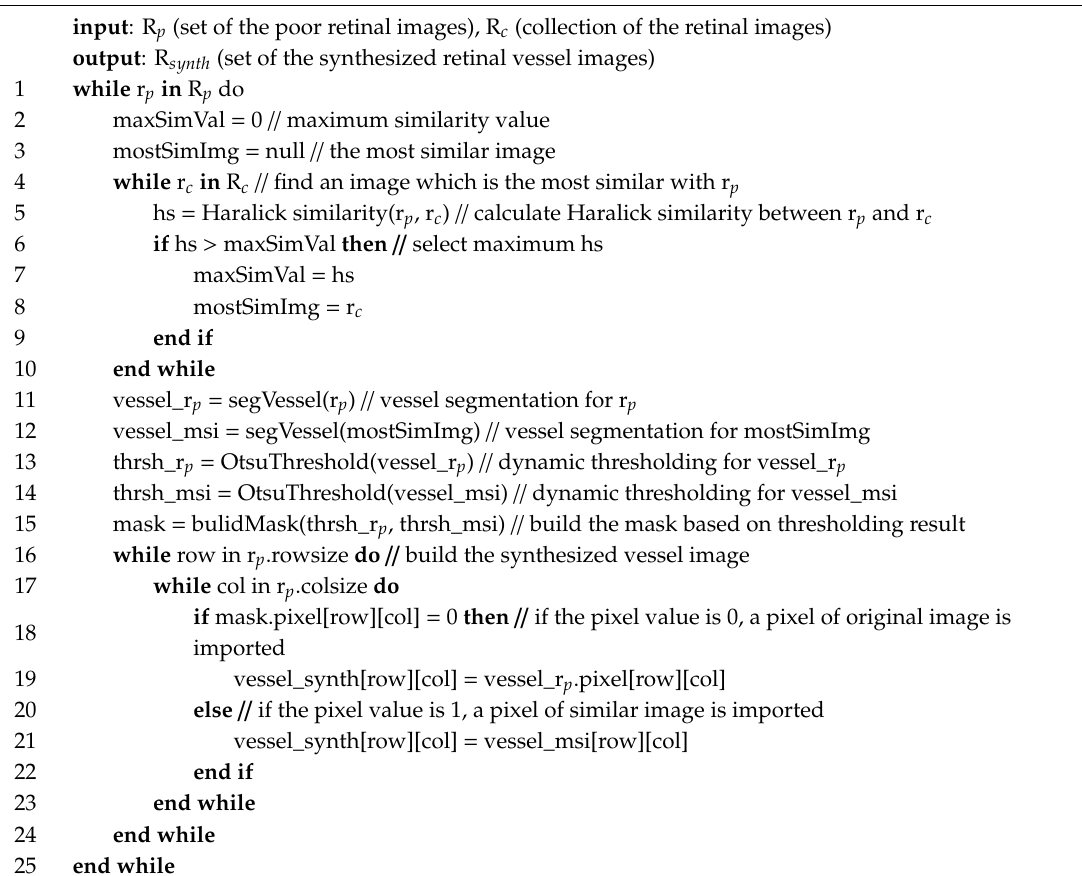
Algorithm 1 Procedure of the proposed